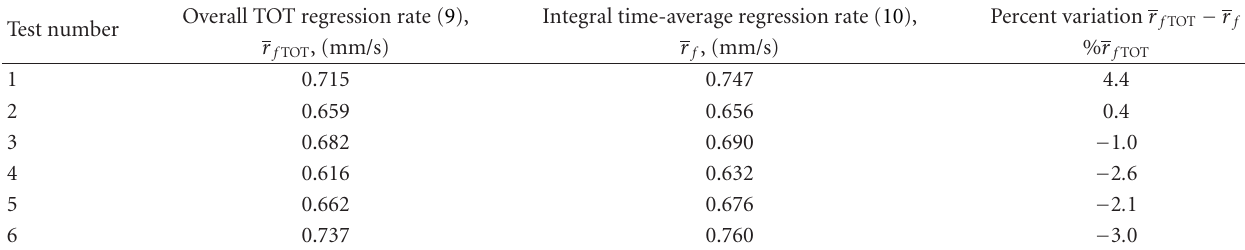
Table 3: HTPB baseline: optimization procedure. Comparison between the two di ff erent techniques implemented to obtain the experimental mean regression